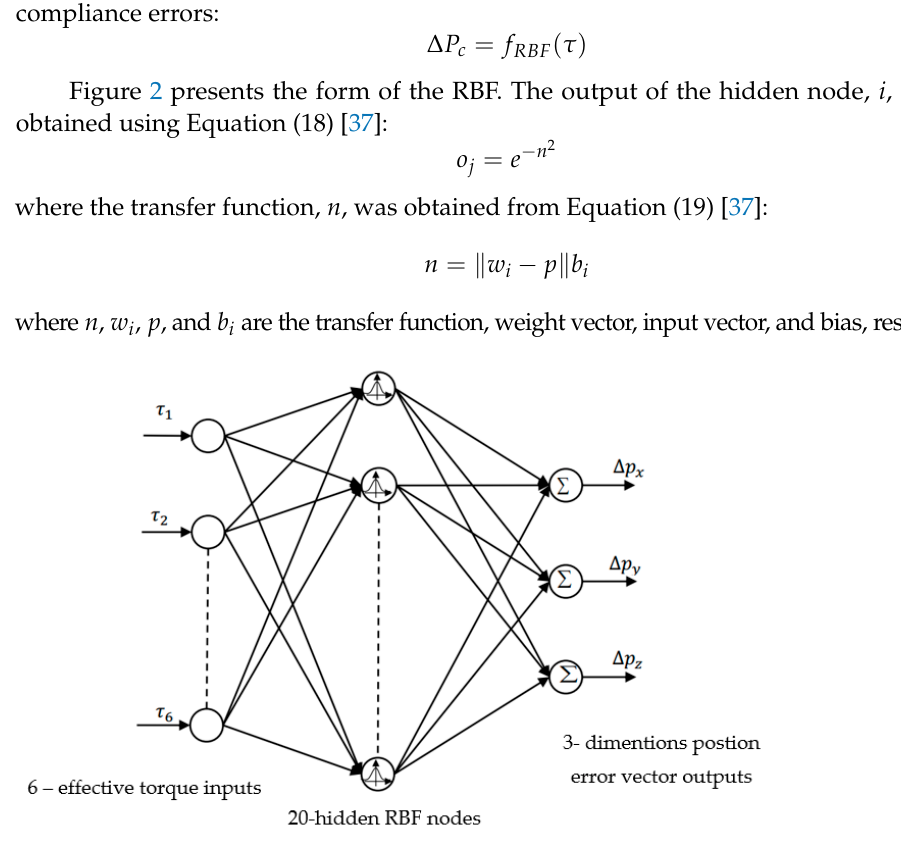
Figure 2. Kinematic structure of the RBF.